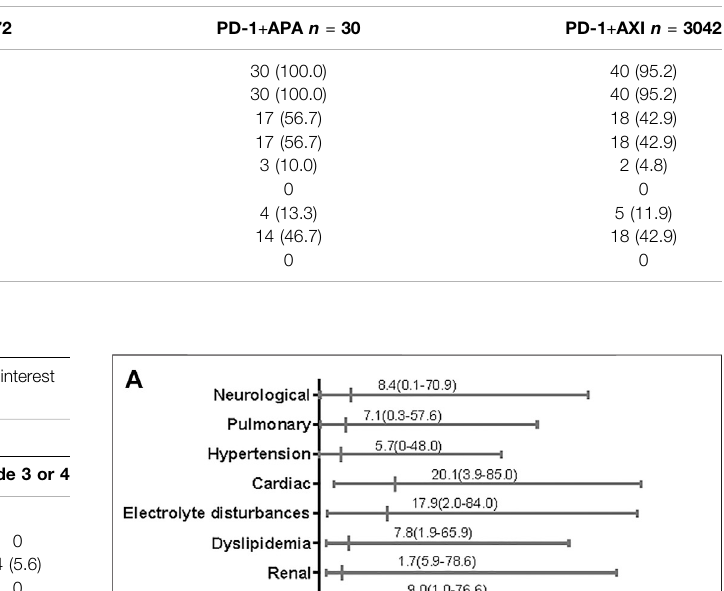
TABLE 2 | Treatment-related adverse events (TRAEs).